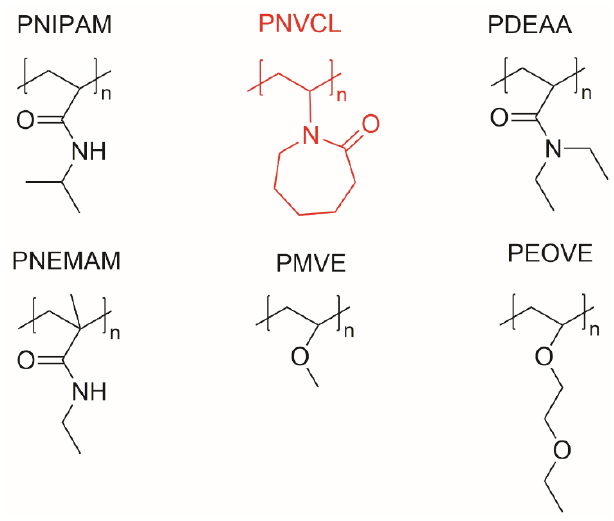
Figure 2. Chemical structures of some thermosensitive polymers.